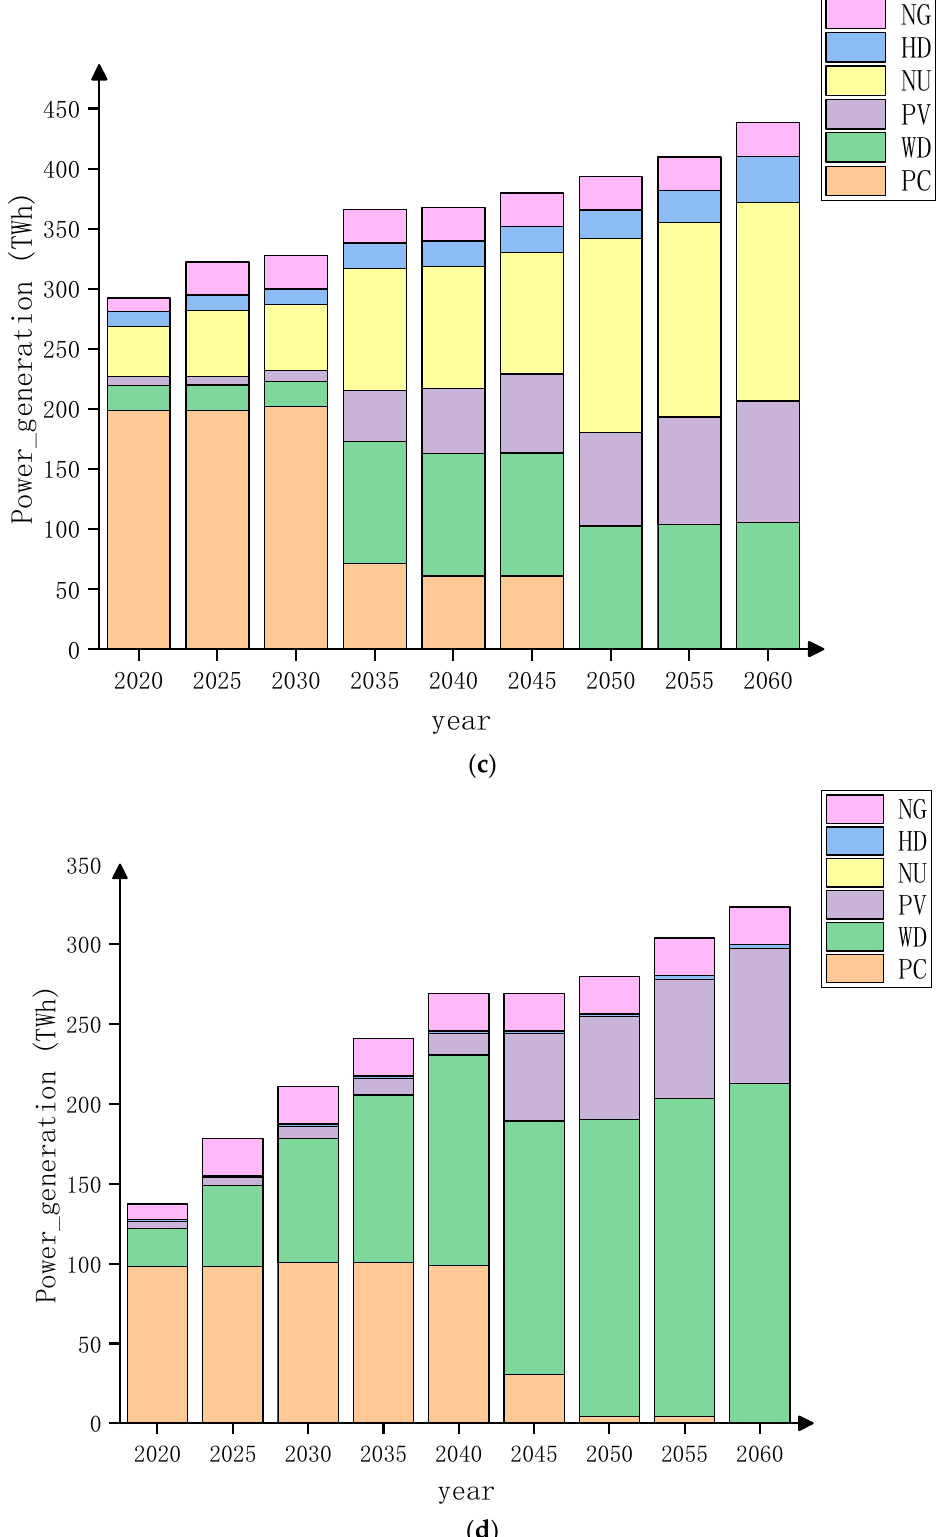
Figure 3. ( a ) Heilongjiang power generation in the BAU scenario between 2020 and 2060. ( b ) Jilin power generation in the BAU scenario between 2020 and 2060. ( c ) Liaoning power generation in the BAU scenario between 2020 and 2060. ( d ) Mengdong power generation in the BAU scenario between 2020 and 2060.